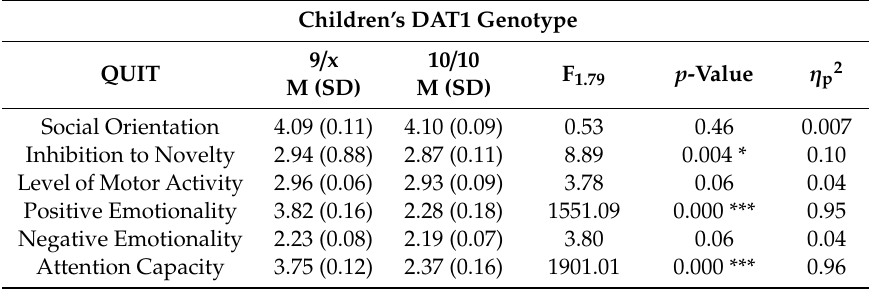
Table 2. Univariate results of the di ff erences between the two groups on children’s temperament.